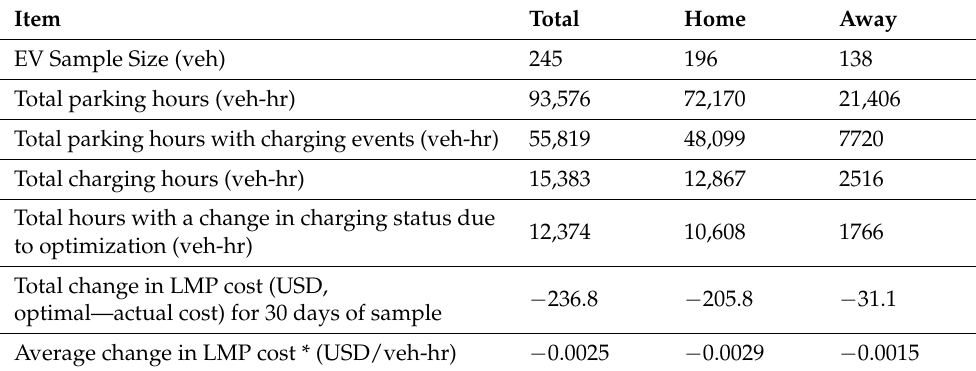
Table 1. Fixed-location result with LMP